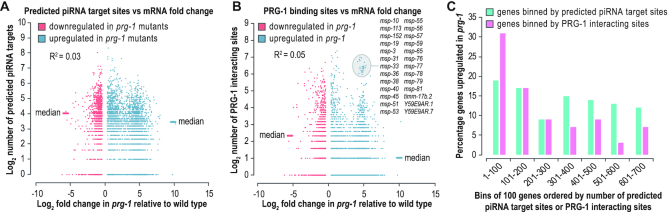
Correlation between piRNA target site abundance and mRNA silencing. (A) Scatter plot displaying each gene misexpressed in the distal gonads of prg-1(n4357) mutants as the log2 number of predicted piRNA target sites it contains (y-axis) versus its log2 fold-change in prg-1 mutants (x-axis). (B) Scatter plot displaying each gene misexpressed in the distal gonads of prg-1(n4357) mutants as the log2 number of PRG-1 binding sites it contains (y-axis) versus its log2 fold-change in prg-1 mutants (x-axis). (C) Bar plot displaying the percentage of genes upregulated in the distal gonads of prg-1(n4357) mutants in bins of genes ranked by either the number of predicted piRNA target sites or the number of PRG-1 interacting sites they contain. The top 700 genes in each category are in sequential bins of 100.